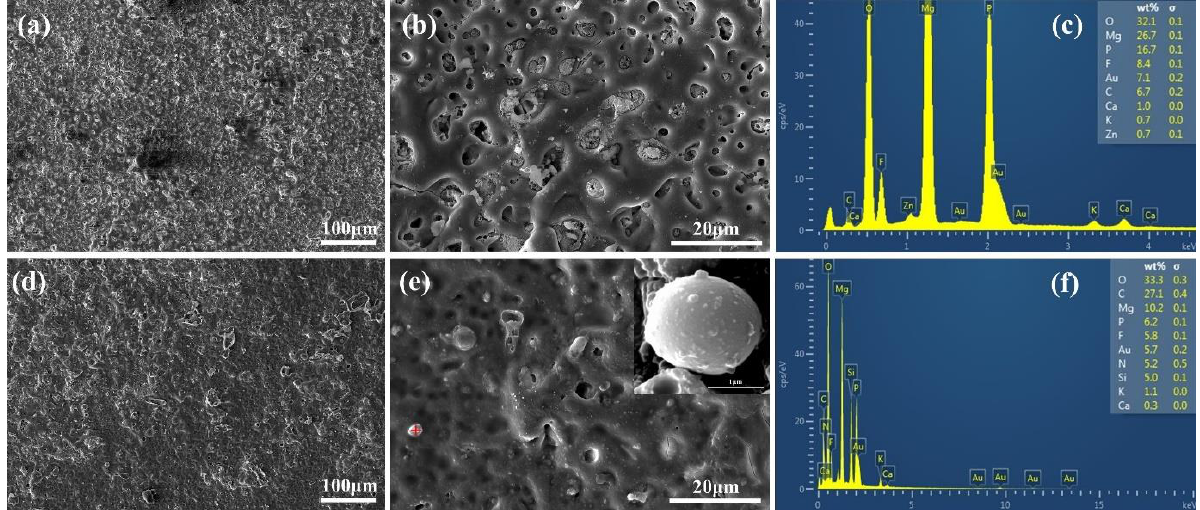
Figure 1. The surface morphology of Mg-based MAO alloy ( a , b ), the surface morphology of Mg- based MAO alloy ( d , e ), “+” in the ( e ) shows the MT particle attached to the MAO film surface, the element content of the MAO film of the Mg-based Mao alloy ( c ), the element content on the MT particle surface ( f ).